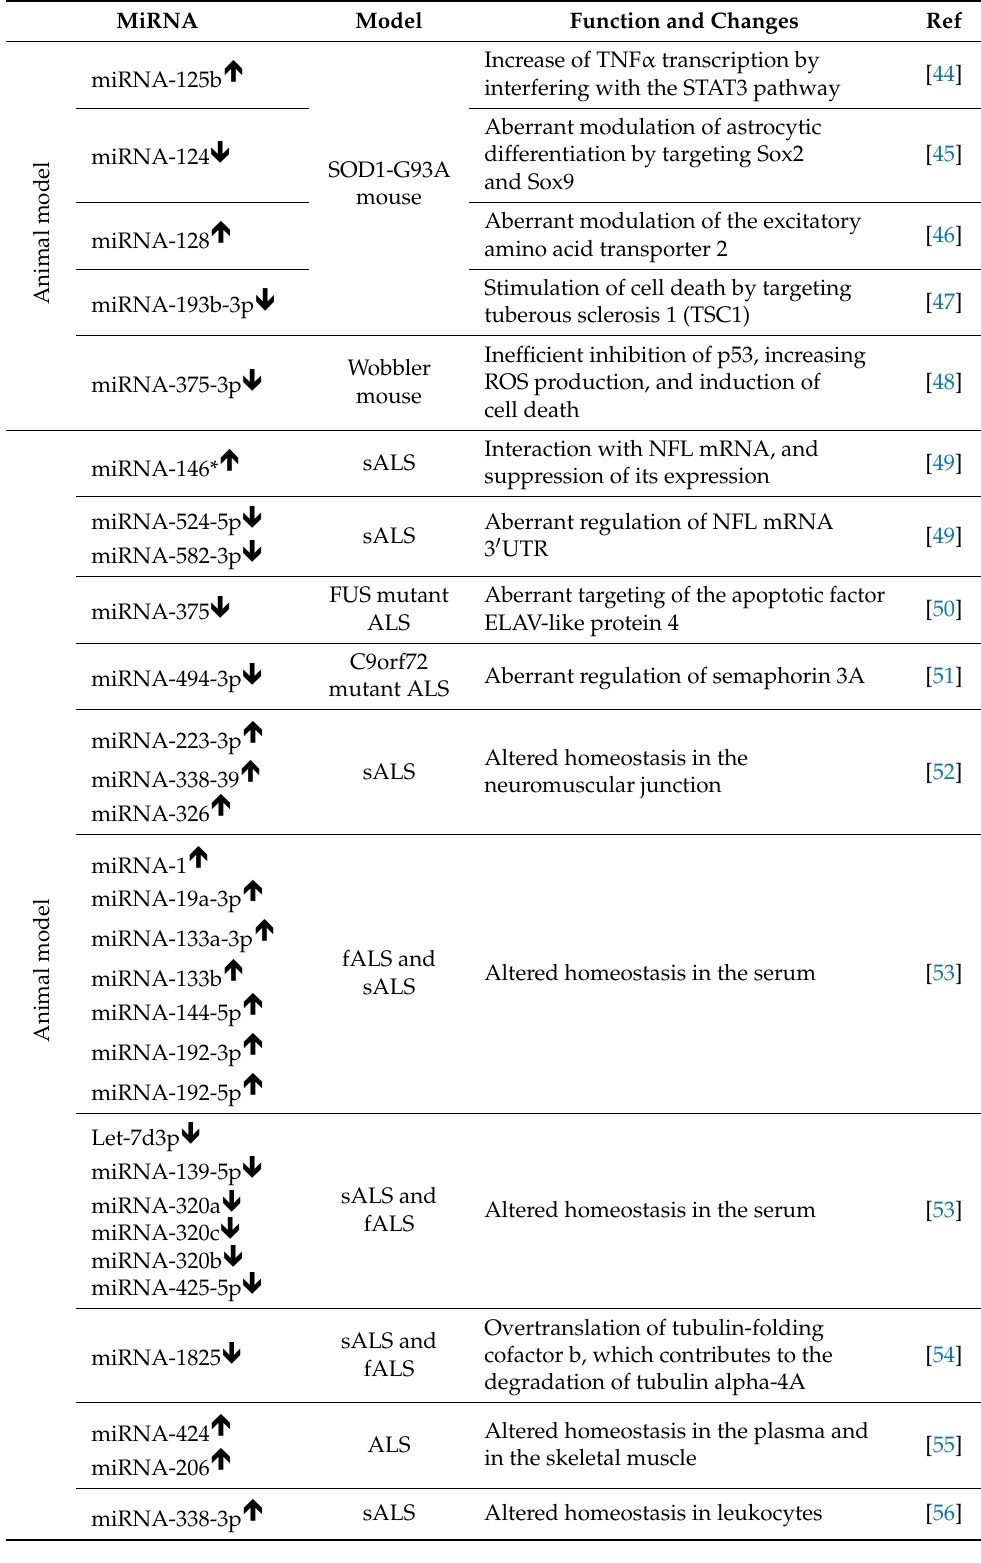
Table 1. Aberrant miRNAs in